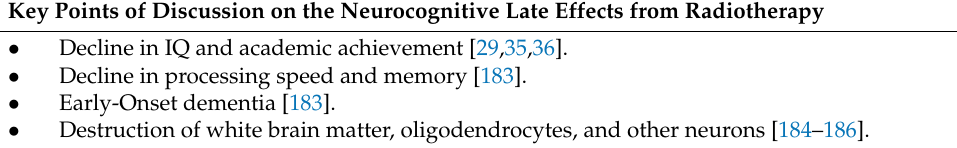
Table 2. Summary of the late effects due to radiotherapy on